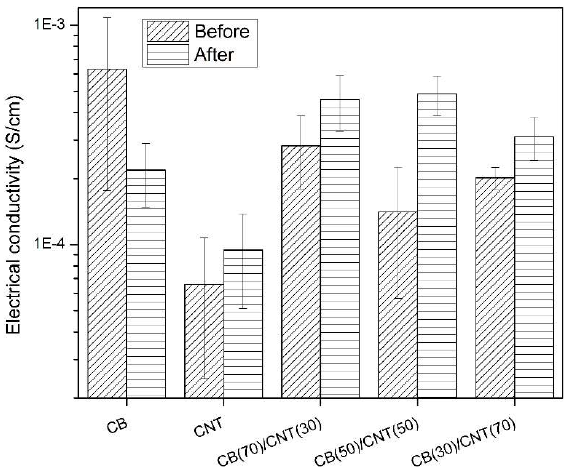
Figure 4. The TD σ for the thick section of different combinations of CB/CNT fillers loaded PS microparts. Results were collected from samples before and after the annealing treatment at 100 °C for 2h.